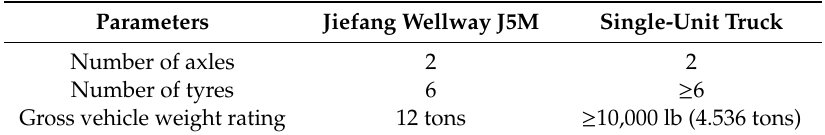
Table 3. Vehicle type in test and